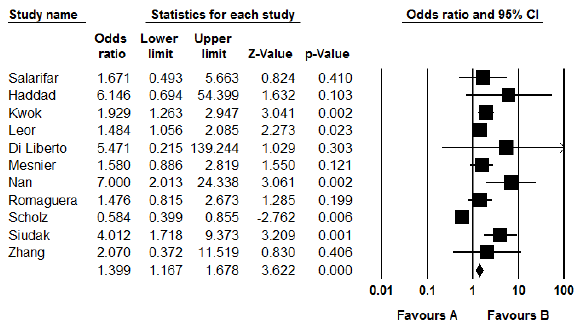
Figure 3 . The hazard ratio in post-STEMI death in the pooled assessment of the studies.